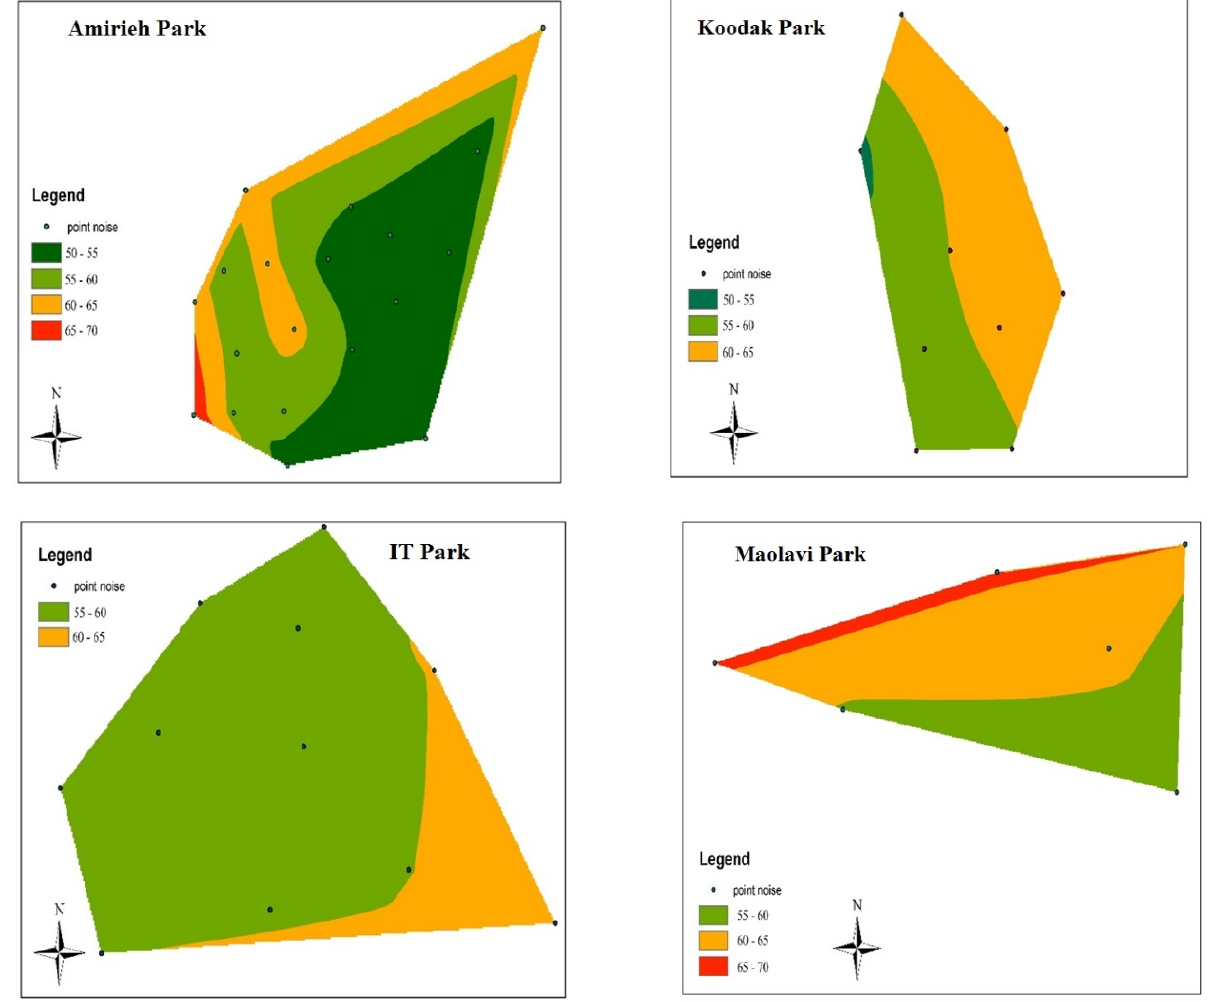
Figure 2. Sound map based on L max in the investigated four parks of Sanandaj